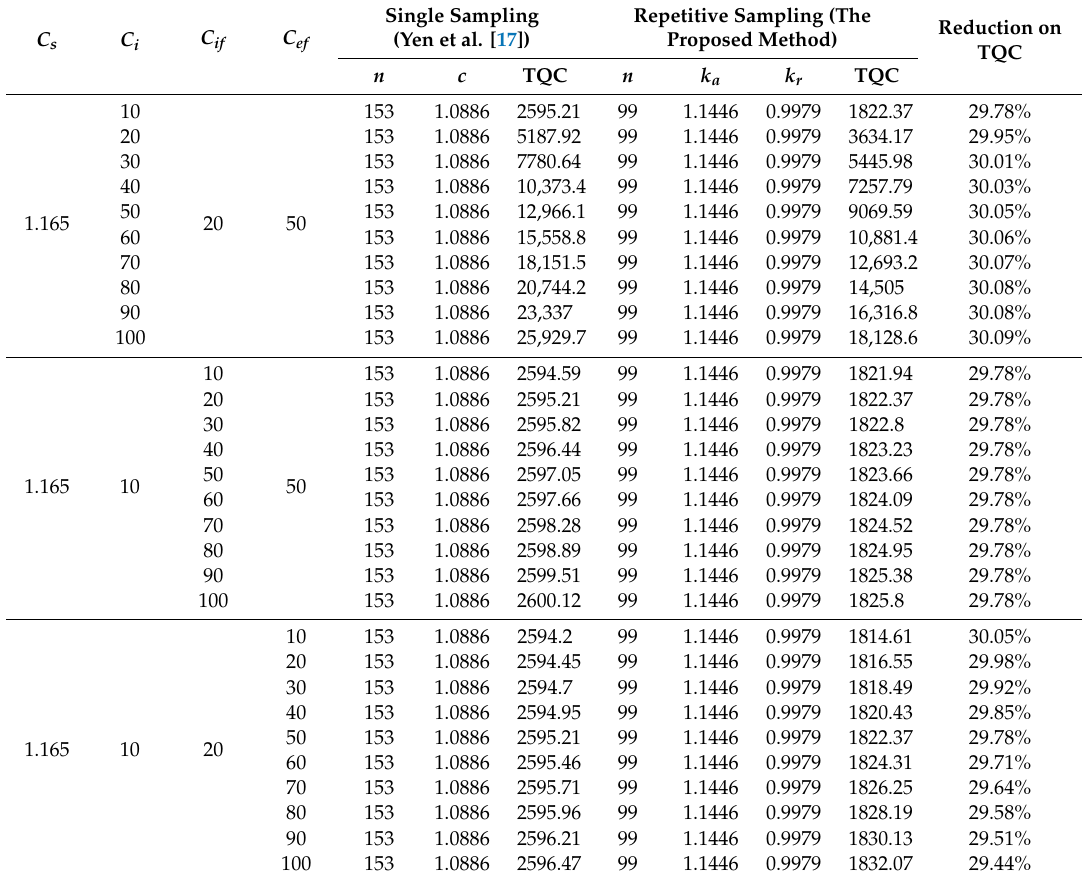
Table 3. Sensitivity analysis of TQC for C i , C if , and Cef.